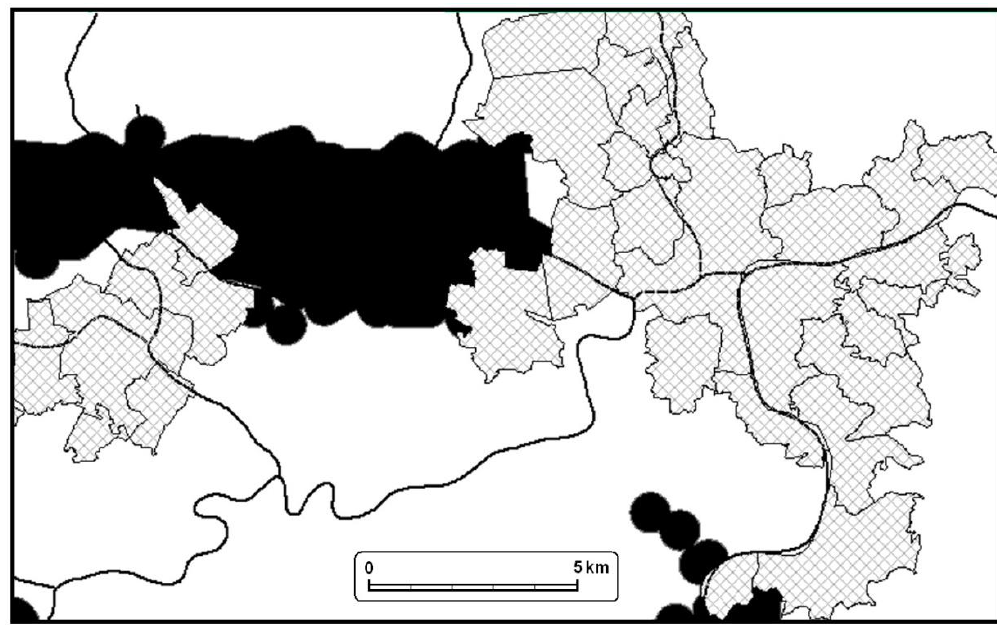
Fig. 4. Removal of areas of indicators of post-industrial landscape in big cities areas and connected areas of indicators smaller than 5 km 2 (Data sources: CENIA, Czech Geological Survey, CORINE LC 2006, Czechinvest, ČÚZaK,